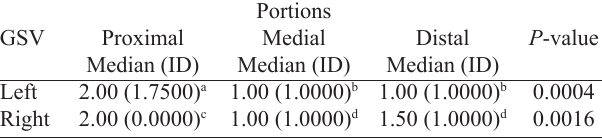
Table 1. The amount allocated between the portions of the GSV.